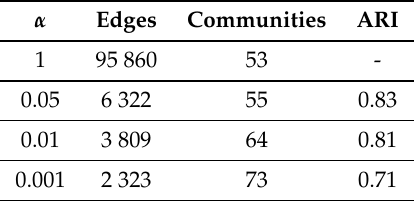
Table 1. Number of edges, communities and ARI when different filtering level is applied.